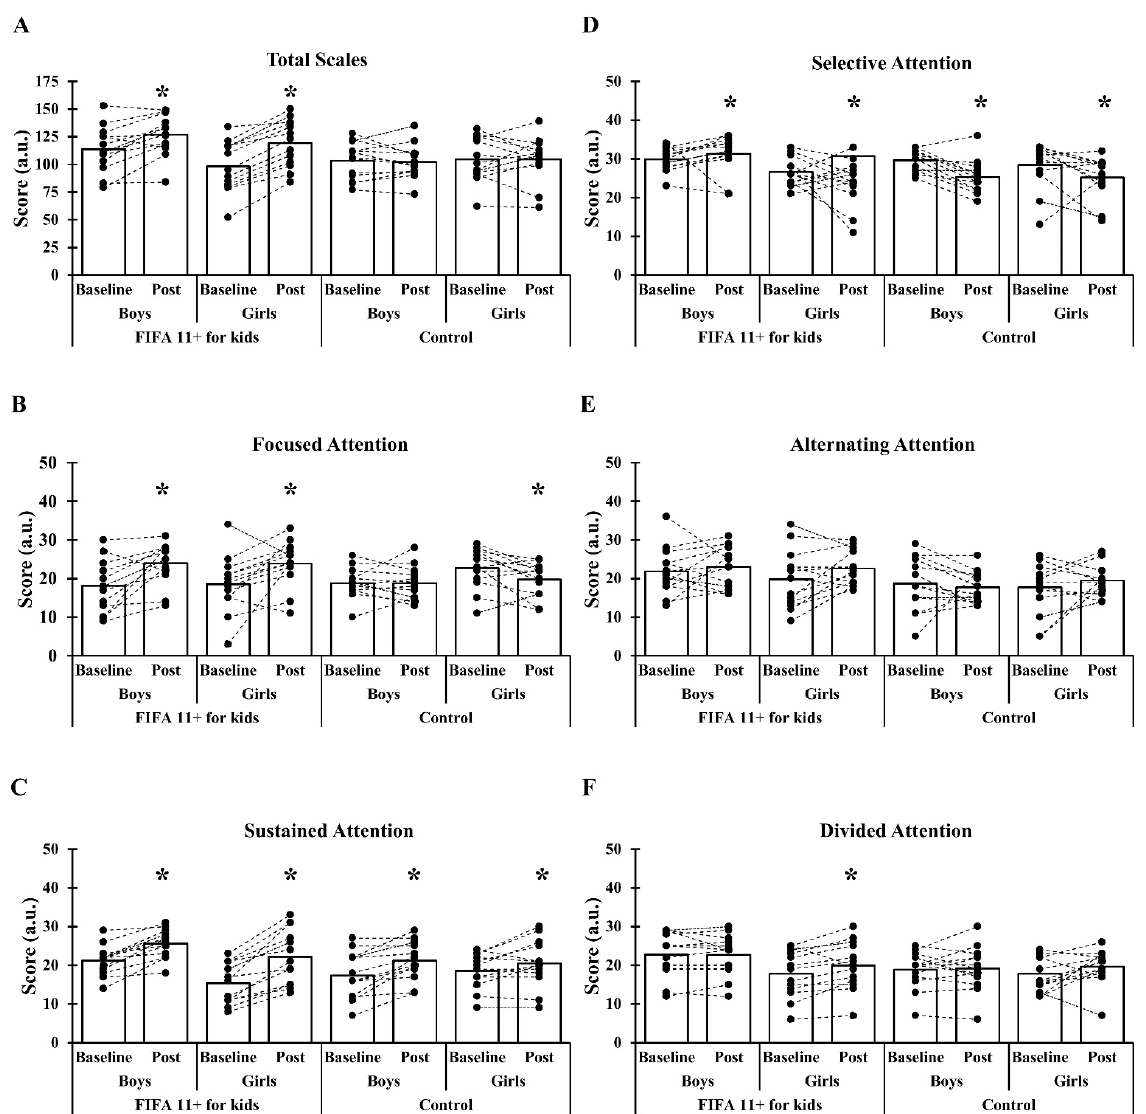
Figure 2. Pooled and individual subscales of the Attention Scale for Elementary School Children test before and after the interventional period in the FIFA 11 + for Kids boys, FIFA 11 + for Kids girls, control boys, and control girls; ( A ) total scale, ( B ) focused attention, ( C ) sustained attention, ( D ) selective attention, ( E ) alternating attention, and ( F ) divided attention. * indicates significant difference in the Wilcoxon test.